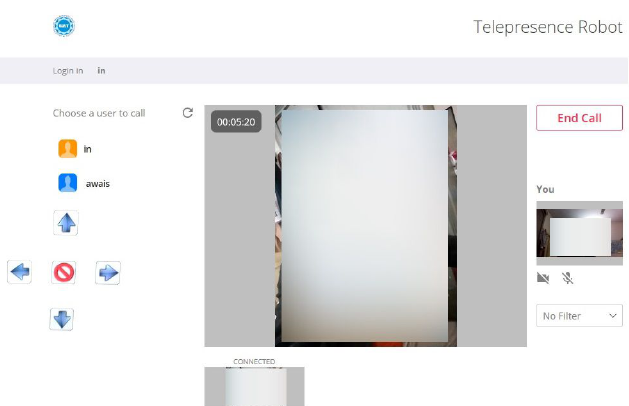
Figure 13. Working of robot during the testing from a remote location.